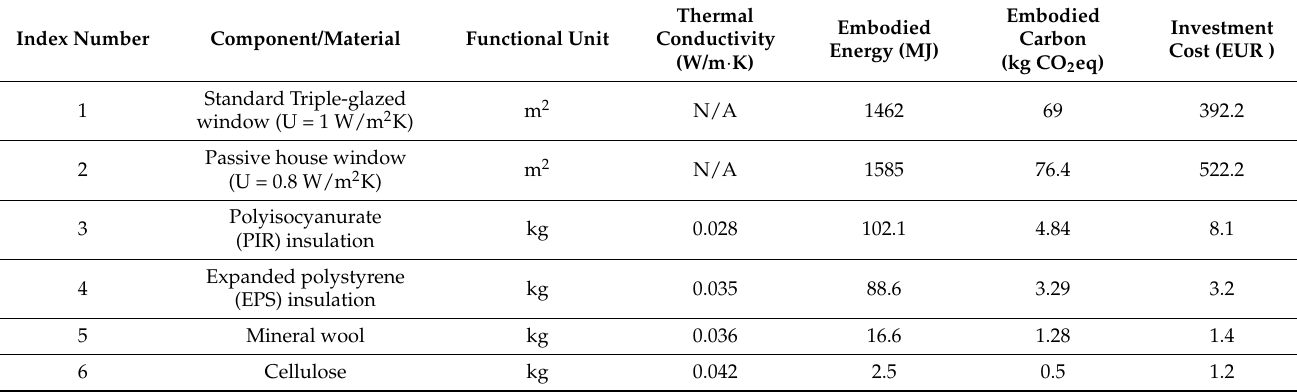
Table 2. A list of the windows and insulation materials that are treated as discrete variables in the optimization. The embodied energy and embodied carbon data were gathered from the Bath ICE [47], the Norwegian EPD foundation [49], and The International EPD system